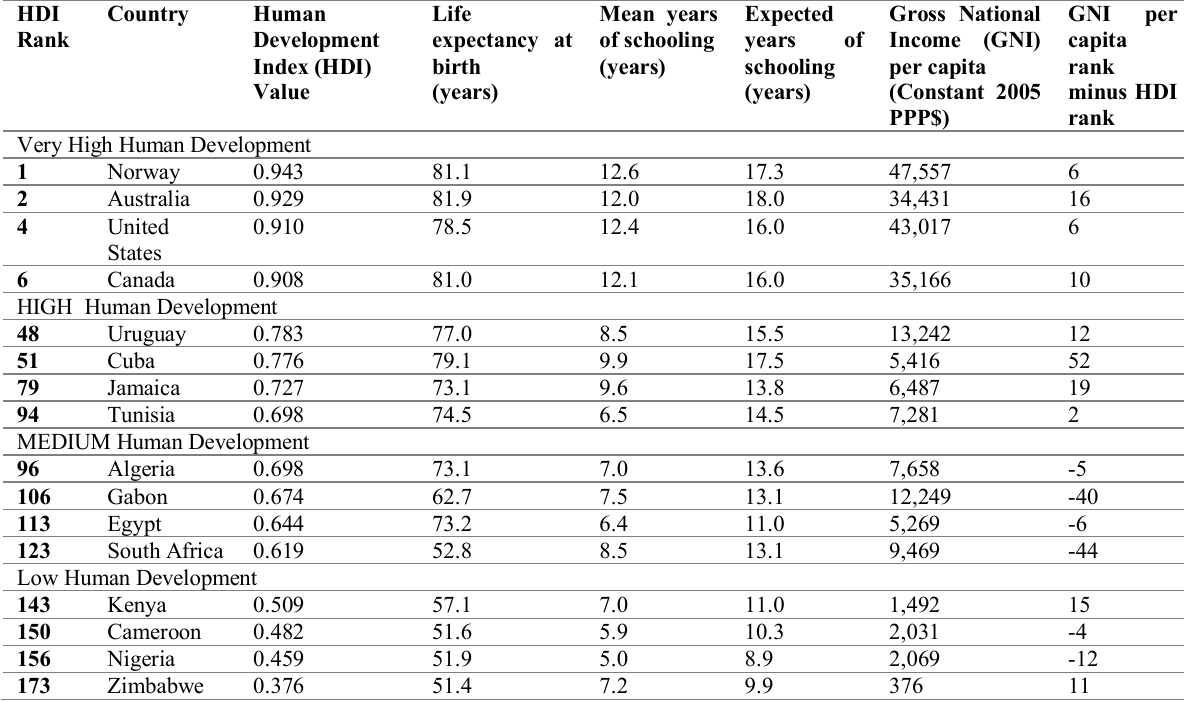
Table 2: Human Development Index and its